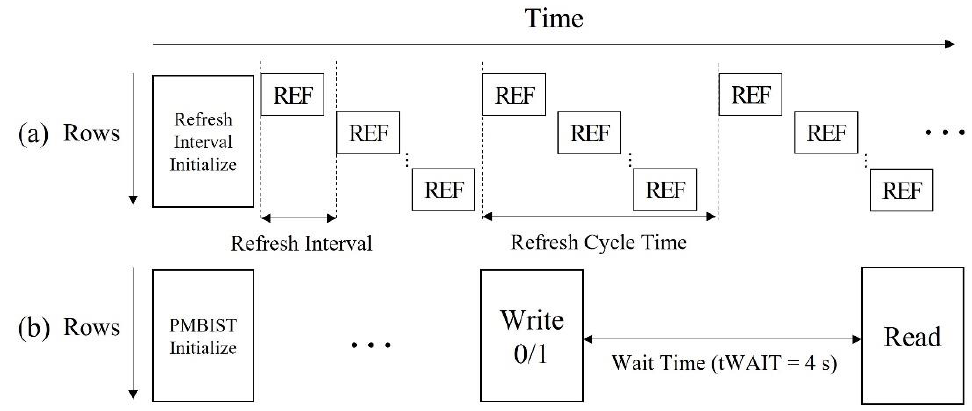
Figure 4. ( a ) Refresh sequences and ( b ) PMBIST operations during the retention test.